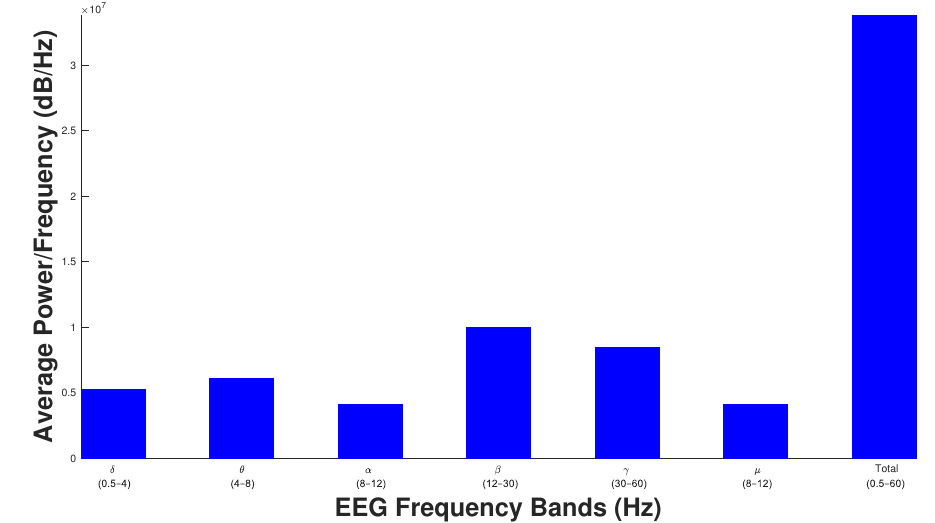
Figure 17. Band-Pass Filtered Spectrogram of an EEG signal by means of the Fast Fourier